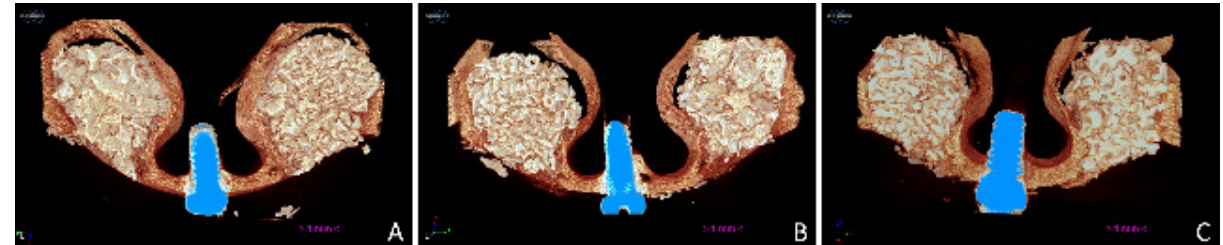
Figure 3. MicroCT 3D images representing the augmented sinus at the 0.125–1 mm and 1–2 mm size granules after 2 ( A ), 4 ( B ), and 8 ( C ) weeks of healing.